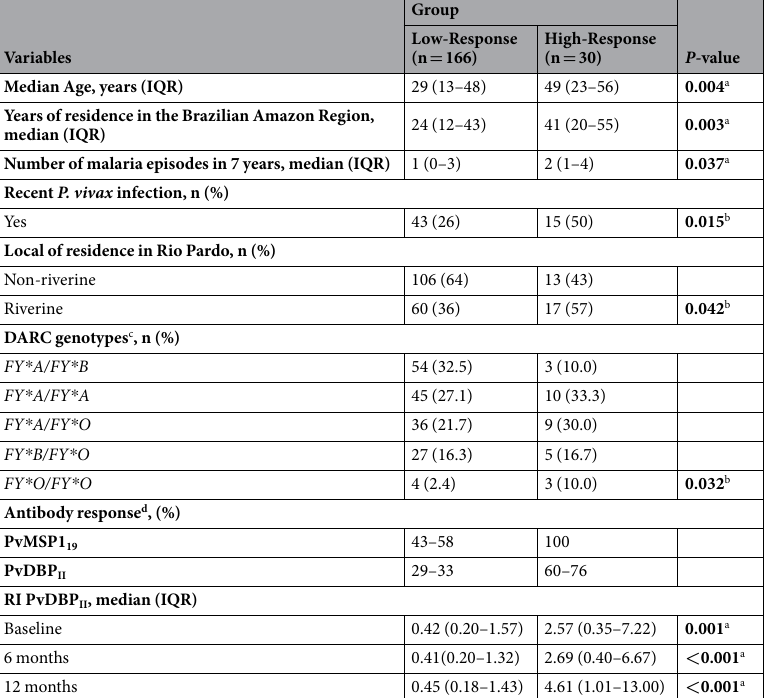
Table 3. Demographic data of the individuals clustered according to the anti-PvMSP1 19 antibody response. a Mann-Whitney U test. b Fisher’s exact test. c Individuals with the FY * B/FY * B genotype were excluded from these analyses due to restricted sample sizes. d Percentage of individuals with a positive antibody response (RI > 1.0) across surveys. The sera reactivity was expressed as the reactivity index (RI) at 492 nm, with RI > 1.0 being considered positive.